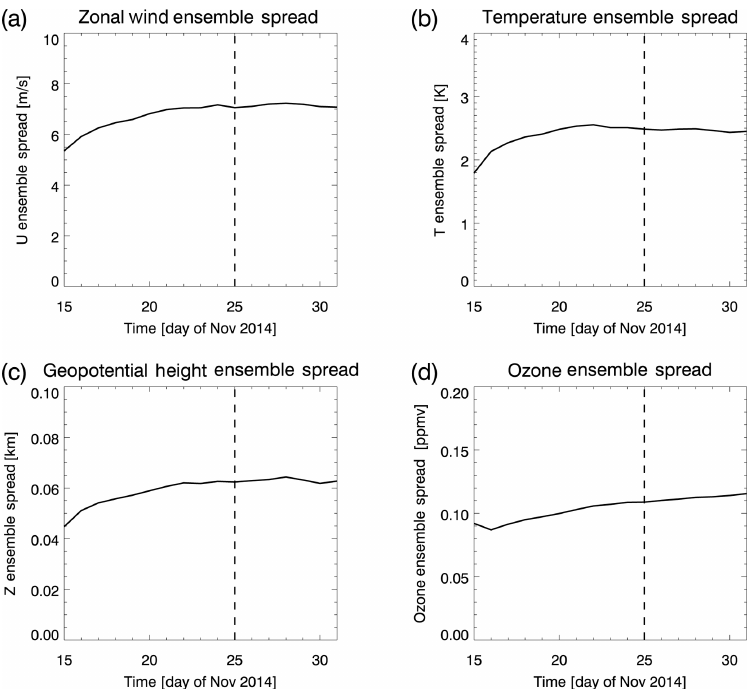
Figure 10. Globally and vertically (from surface to model top) averaged (surface to model top) ensemble background error standard deviation (or “spread”) for 15 November–1 December 2014, evaluated at 00:00Z for each day. Panels are for (a) zonal wind (ms − 1 ), (b) temperature (K), (c) geopotential height (km), and (d) ozone (ppmv). The dashed line on 25 November indicates the end of the spin-up